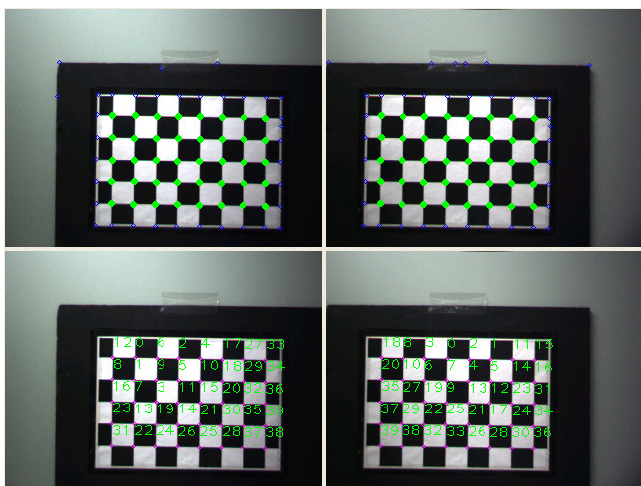
Figure 18. Examples of captured stereo images and their feature locations extracted through the automatic detection process.